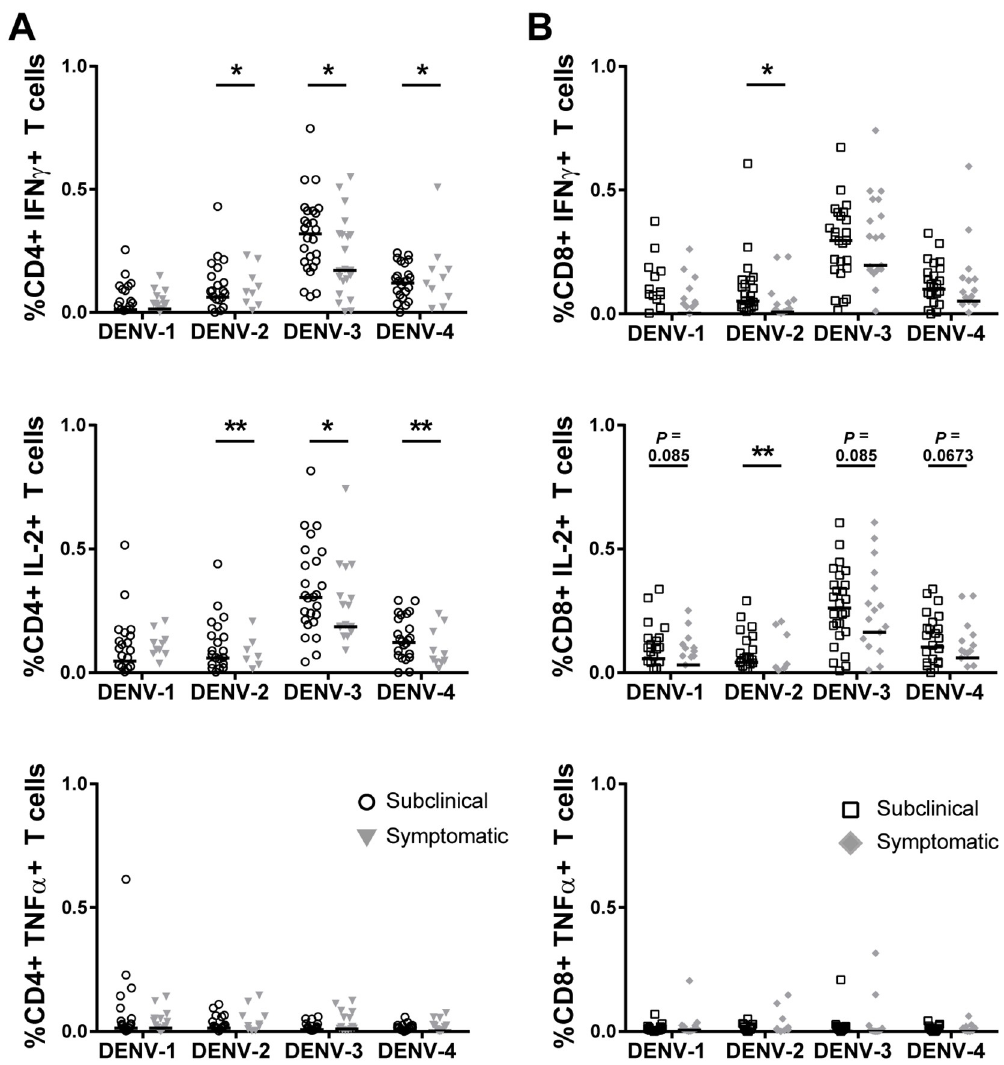
response to DENV-1-4 inactivated antigen stimulation of PBMC from Thai schoolchildren. Comparison groups are PBMC from children who later developed subclinical (open symbols) or symptomatic (closed symbols) infections. The Wilcoxon rank-sum test was used to compare cytokine production between the two groups ( � p < 0.05, �� p < 0.01). Data are presented relative to the negative control (responses to negative control stimulation were subtracted